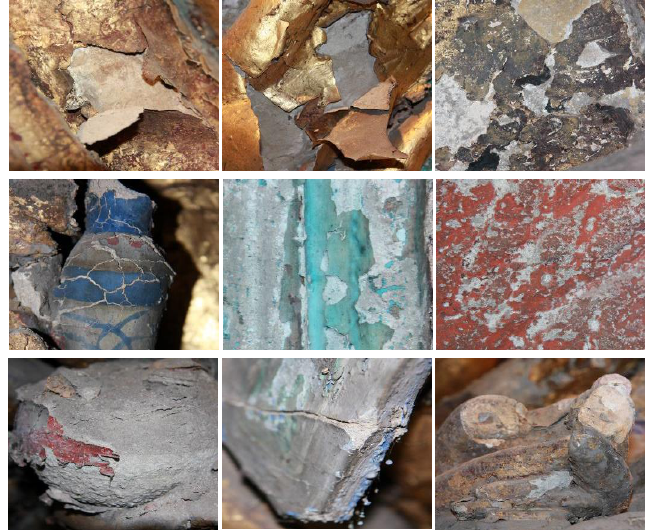
Figure 1. Typical damage found in gold foil (fall-off, curling, cracking, etc. ).